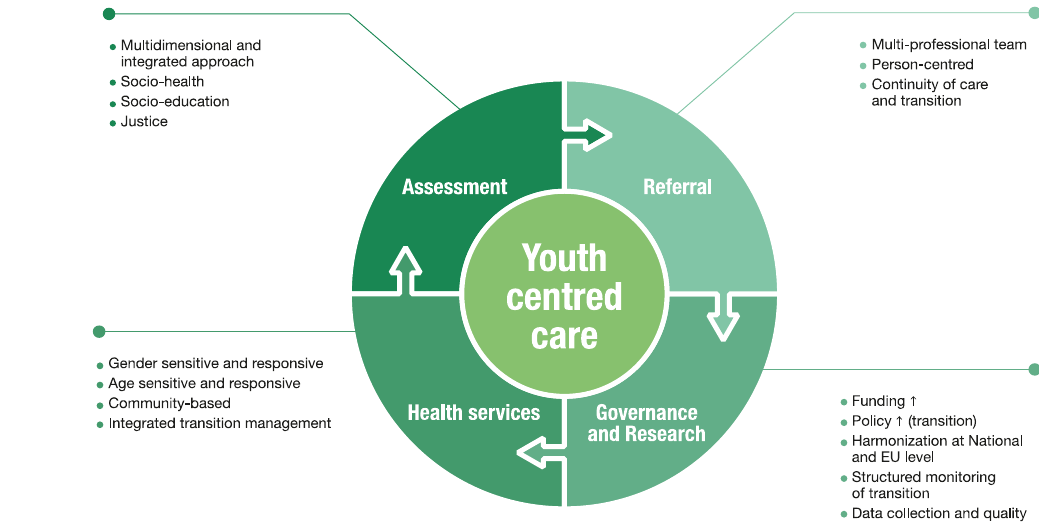
Figure 1. Youth-centred care framework for the structural strengthening of the healthcase system. Design of mental health services across adolescence and the transition to adulthood represents a blueprint for an overdue global system reform. While resources will vary across settings, the mental health needs of young people are largely universal and underpin a set of fundamental principles and design features. These include the introduction of a soft entry point for youth mental health platform, where young people are part of a co-creative development process.